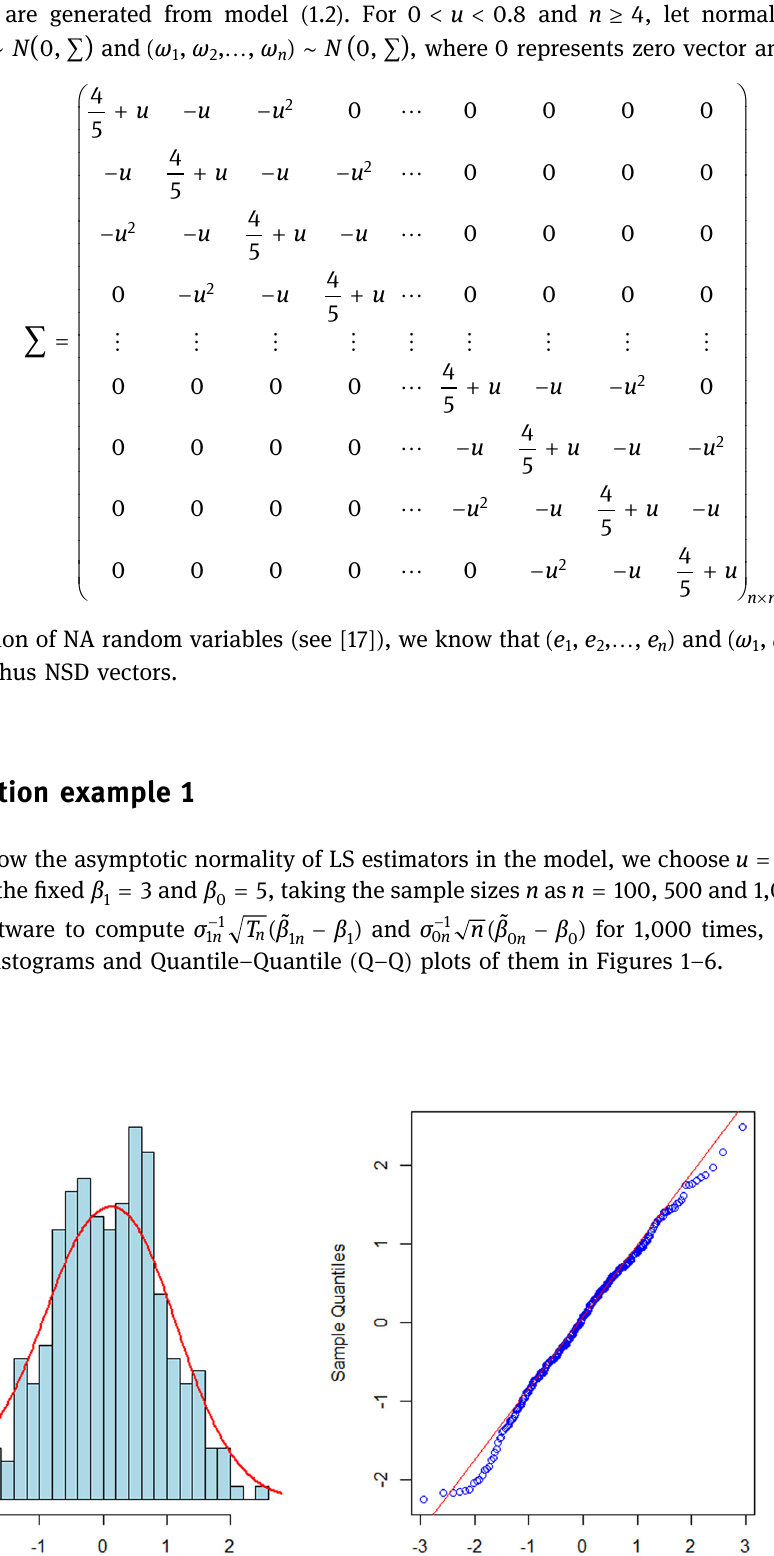
Figure 1: Histogram and normal Q – Q plot of ( ) ≜ σ T β β μ ˜ − n n